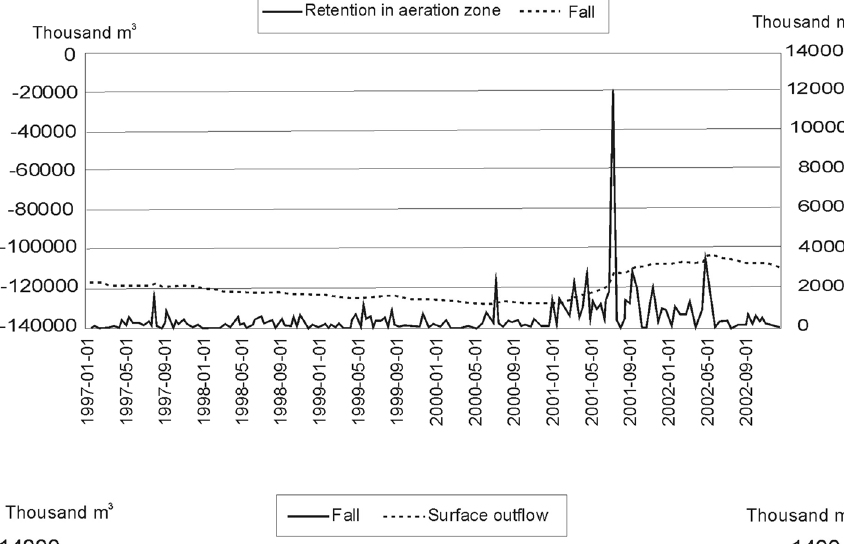
Fig. 9 Surface outflow in Potok Oliwski